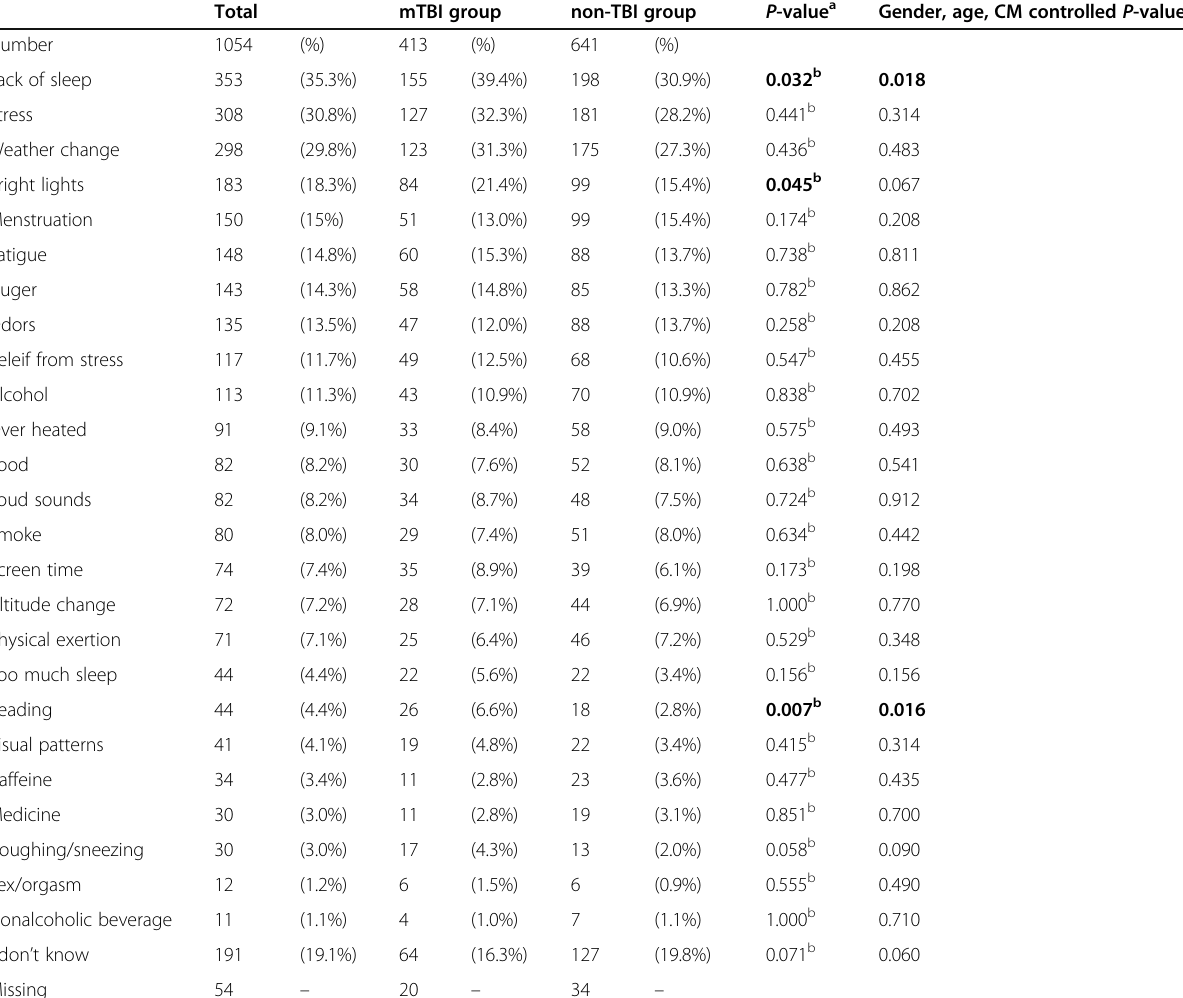
Table 4 Headache